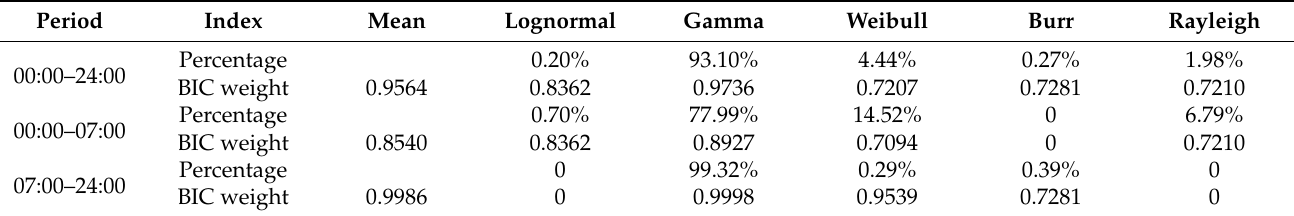
Table 3. Statistics of best-fit distributions for travel distance.